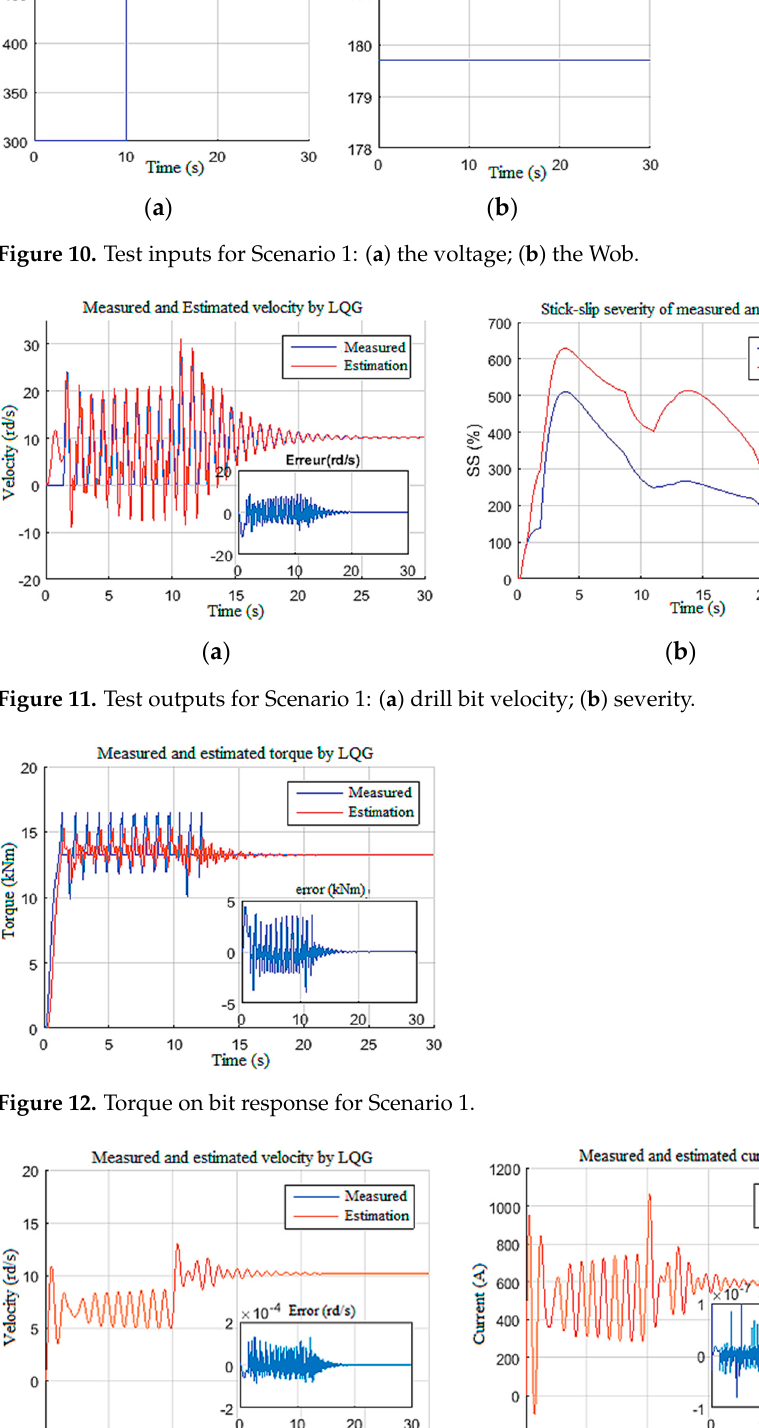
Figure 10. Test inputs for Scenario 1: ( a ) the voltage; ( b ) the Wob.